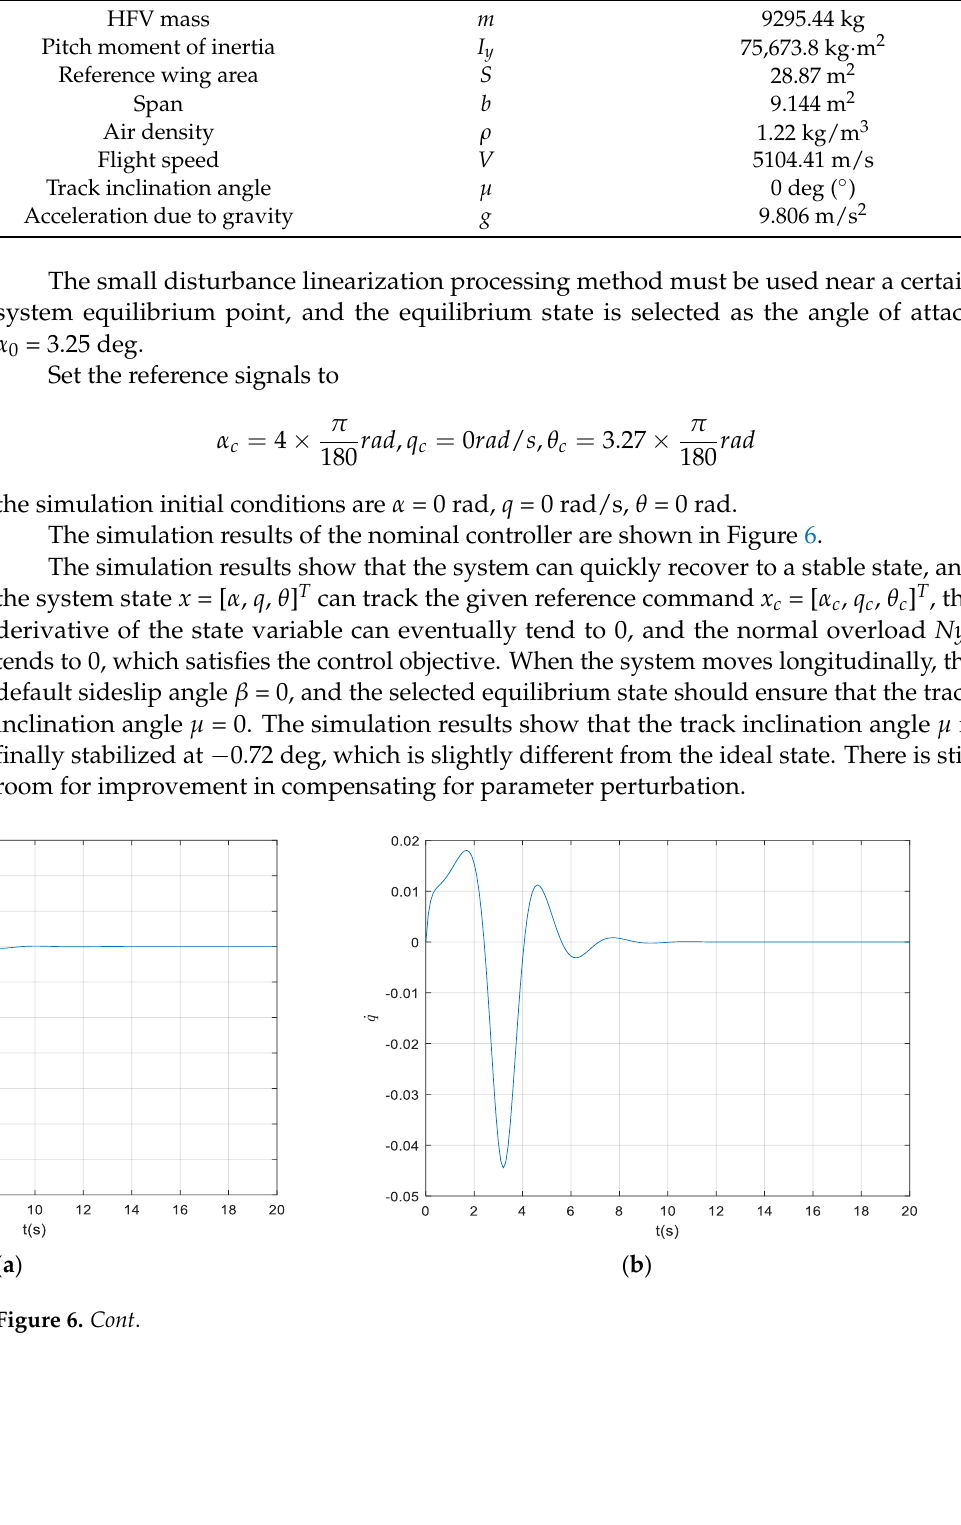
Table 2. HFV simulation control